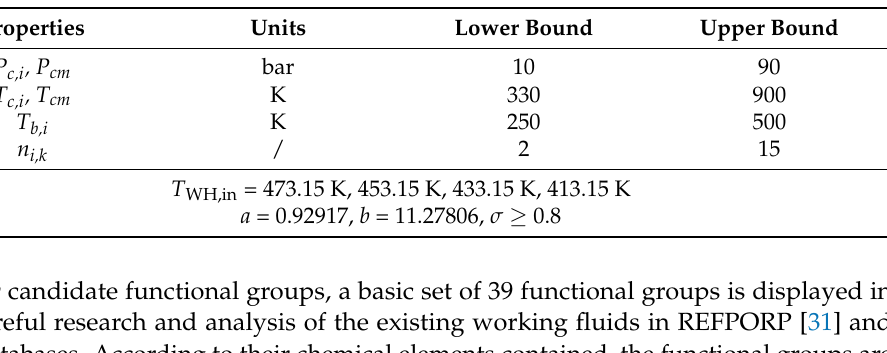
Table 1. The fixed parameters for the design